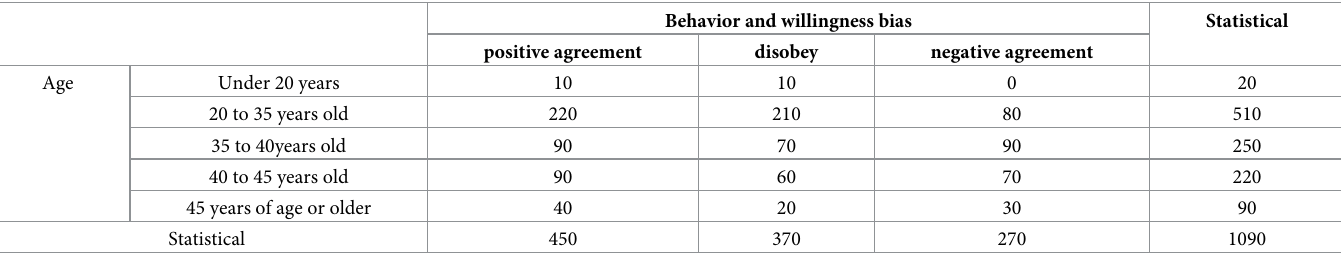
Table 5. Cross analysis of age-dependent